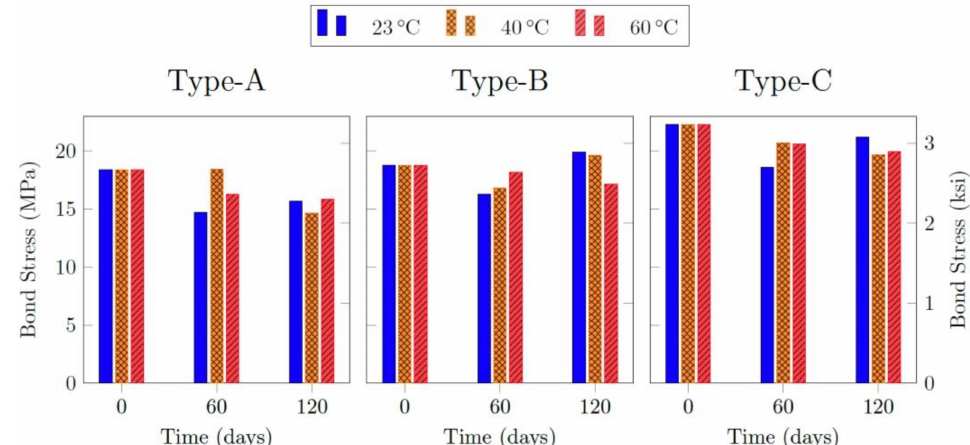
Figure 5. Bond strength development over time (rebar types A, B and C).